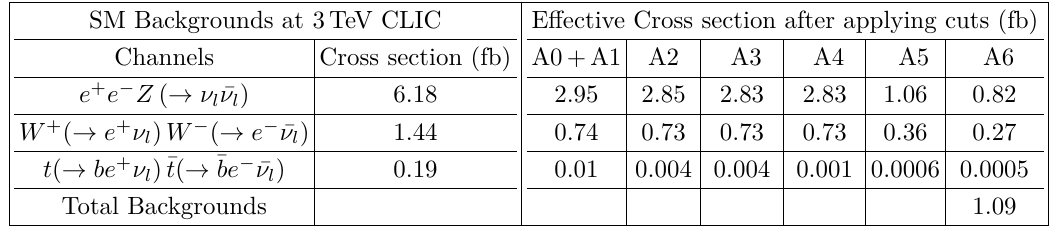
Table 5 . Cut-flow table for the obtained cross sections corresponding to the SM backgrounds. The details of the cuts A0-A6 are mentioned in the text. We perform the simulation for 3 TeV CLIC. Signal at e + e − Collider Effective CS after cuts (fb) Stat Significance ( S )